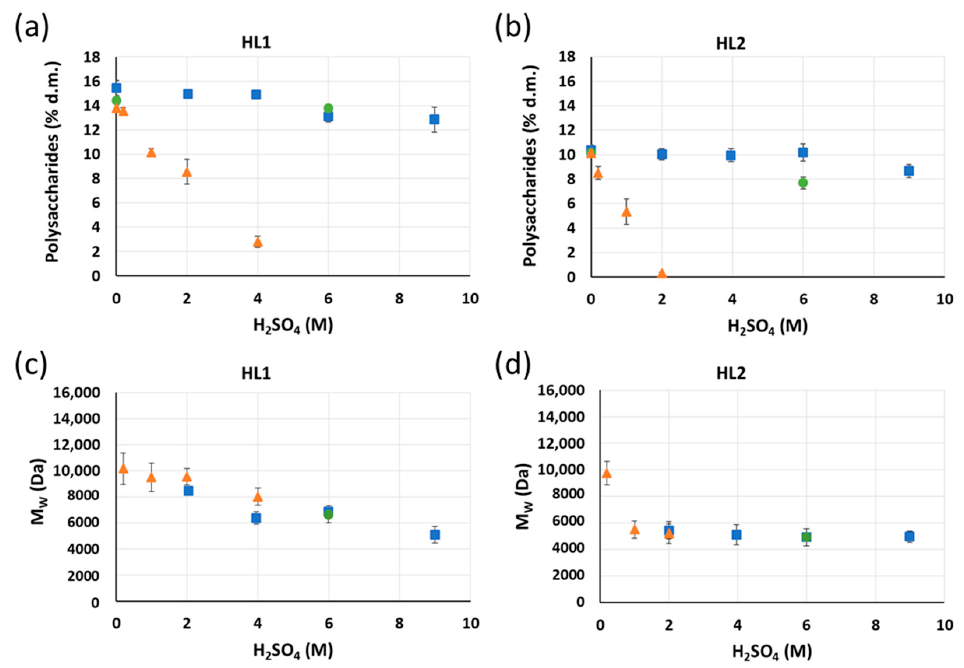
Figure 6. Concentration of polysaccharides in ( a ) HL1 and ( b ) HL2 and average M w of ( c ) HL1 and ( d ) HL2 lignins after 1 h of acid hydrolysis treatment at different H 2 SO 4 concentrations and temperatures ( 30 °C; 70 °C; 120 °C). Yields of purified lignins ≥ 95%. Standard deviation error bars of duplicate experiments.